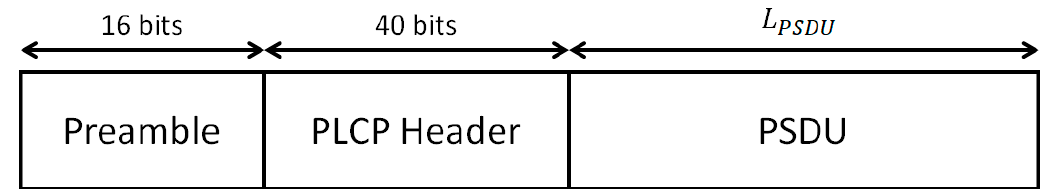
Figure 2. SmartBAN frequency spectrum.